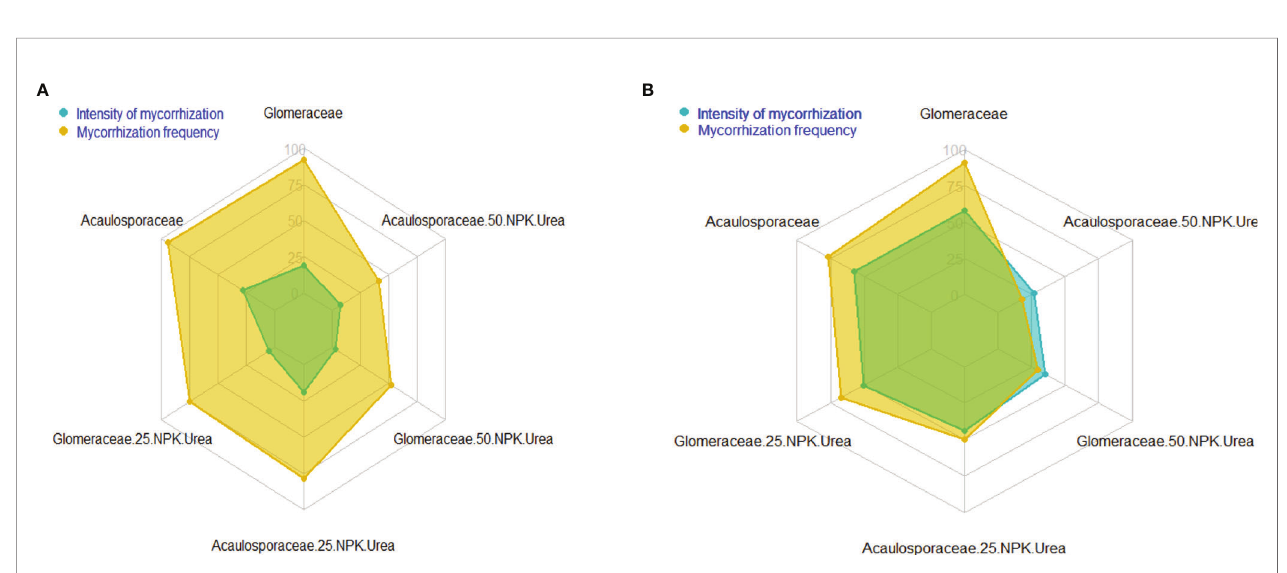
FIGURE 5 | Mycorrhization variables in the greenhouse (A) and the fi eld (B) .